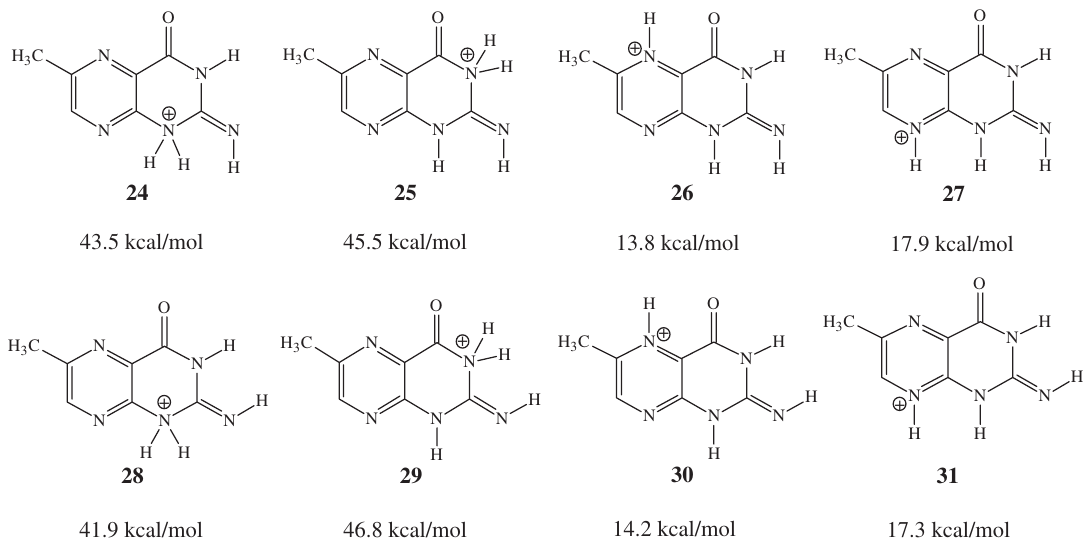
Figure 7 Relative calculated energies of pterins resulting from the ring nitrogen protonation of the guanidinyl lactam structures, 5 (top) and 6 (bottom).